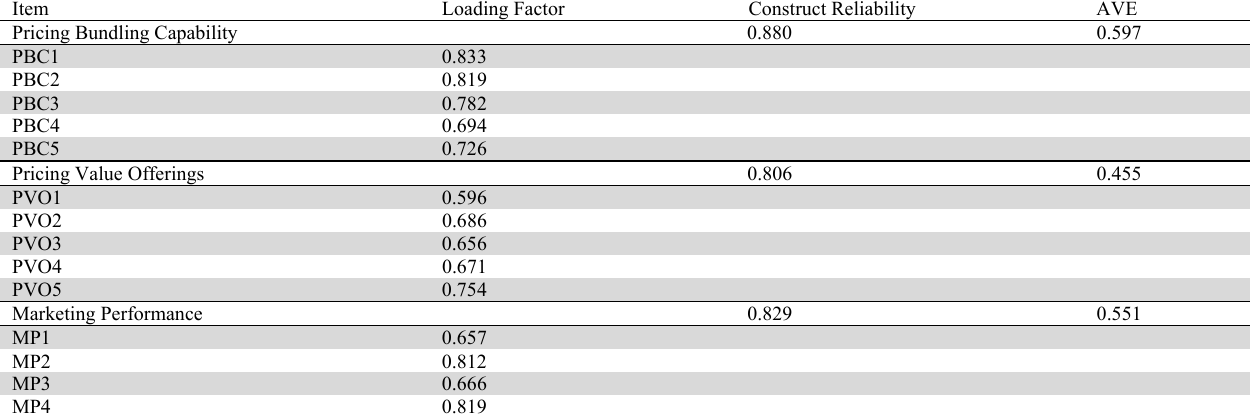
Loading Factor, Construct Reliability and